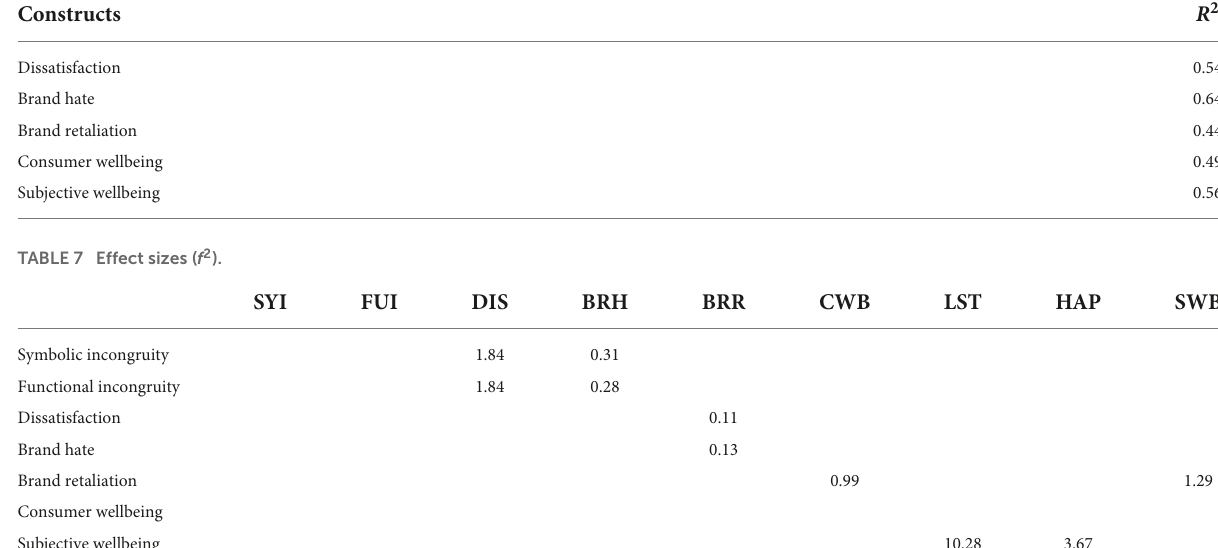
TABLE 6 Coefficients of determination ( R 2 ).